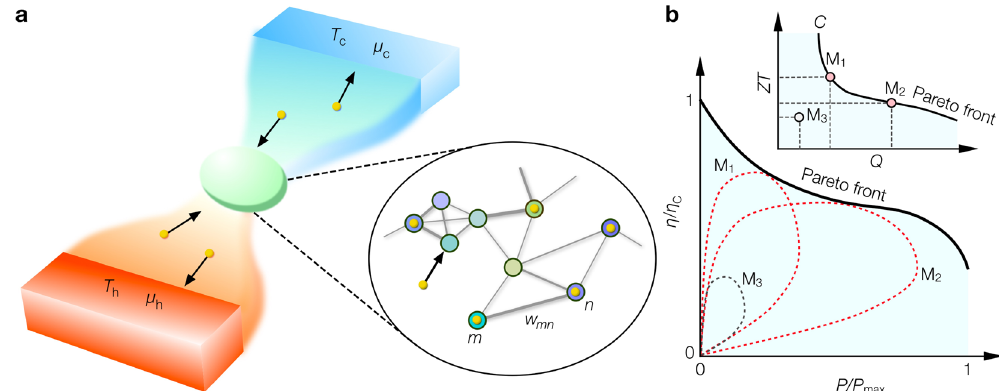
Fig. 1 Graphical representation of interacting nanothermoelectric and characterization of the best heat engines. a Nanoscale heat engine is characterized by a network, in which each node represents a single-particle level labeled by an integer like m , n . Each edge connecting two nodes indicates the presence of interaction between the corresponding single-particle levels (in, e.g., quantum dots). The width of the edge between node m and node n is labeled by w mn , and represents the interaction strength. The system is connected with hot (h) and cold (c) reservoirs at temperatures T h,c and electrochemical potentials μ h,c . Each node exchanges electrons with the reservoirs and can be occupied by at most a single electron. b Set of the best heat engines is characterized by the best trade-off (known as the Pareto front) between their power P and ef fi ciency η (thick solid curve in the main panel). The inset illustrates the concept of dominance in terms of power factor Q and fi gure of merit ZT ; machines M 1,2 dominate M 3 , while there are no dominance relations between M 1 and M 2 . The Pareto front C in the inset is de fi ned by the Pareto-optimal machines (such as M 1 and M 2 ) that are not dominated by any other ones. The dashed loops in the main panel indicate the power-ef fi ciency curves with varying chemical potentials at fi xed Q and ZT (cf. Eq. (4)), which correspond to machines M 1,2,3 indicated in the inset. The envelope of all the possible loops provides the Pareto front on the P – η plane in the main panel. The ef fi ciency and power are normalized by the Carnot ef fi ciency η C and the maximum power P , max